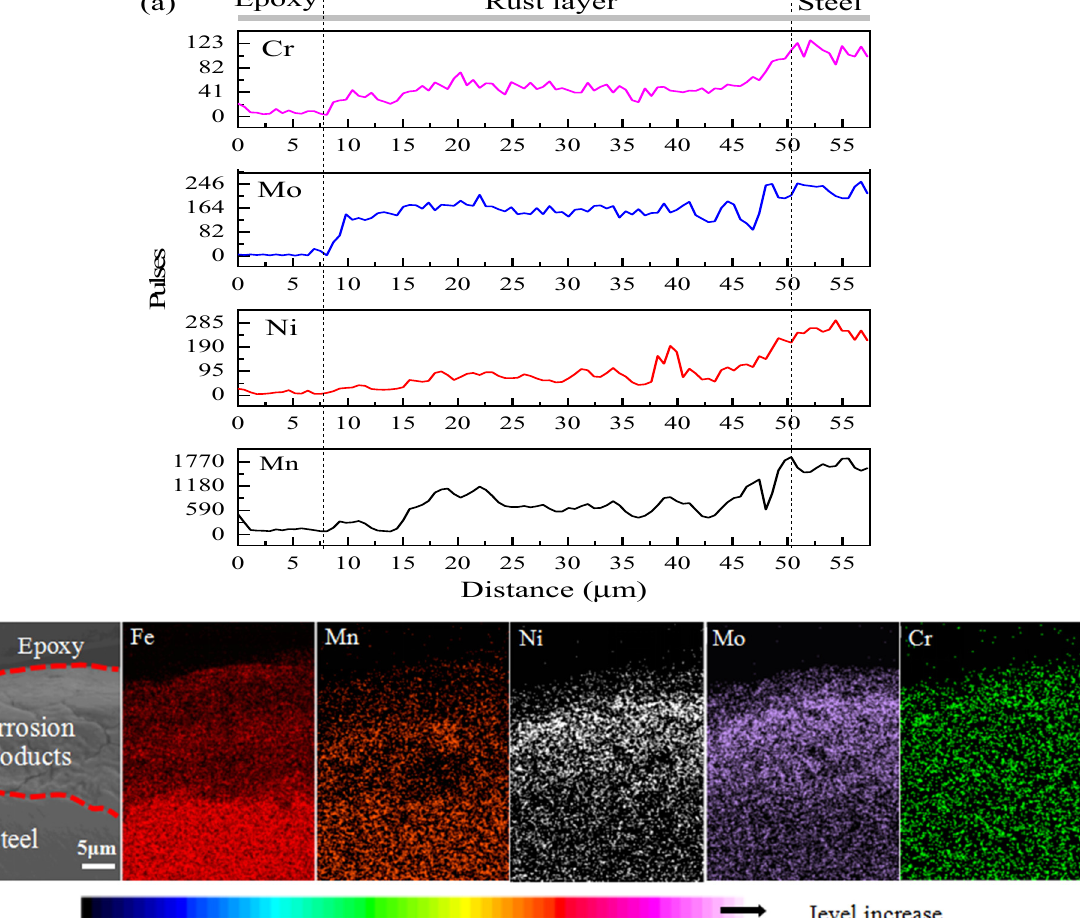
Figure 6. The distribution of elements in corrosion products of test steel: ( a ) the results of EDS line scan for 24 h; ( b ) results of EDS surface scan for 600 h.